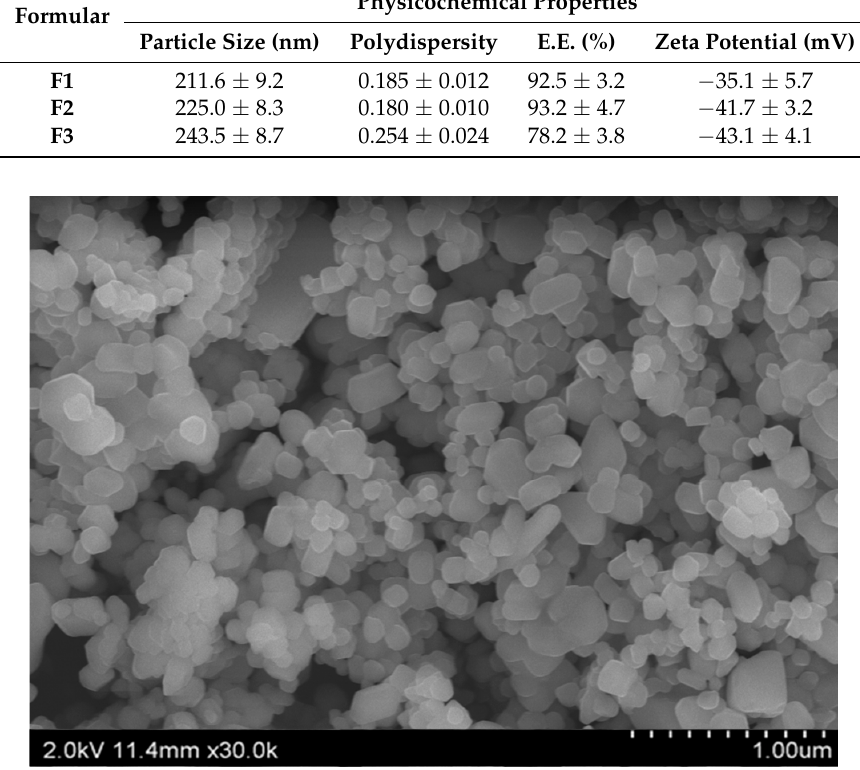
Table 2. The particle size, polydispersity, and encapsulation efficiency (E.E) of different SLNs. Data are expressed as the mean ± SD ( n = 3).